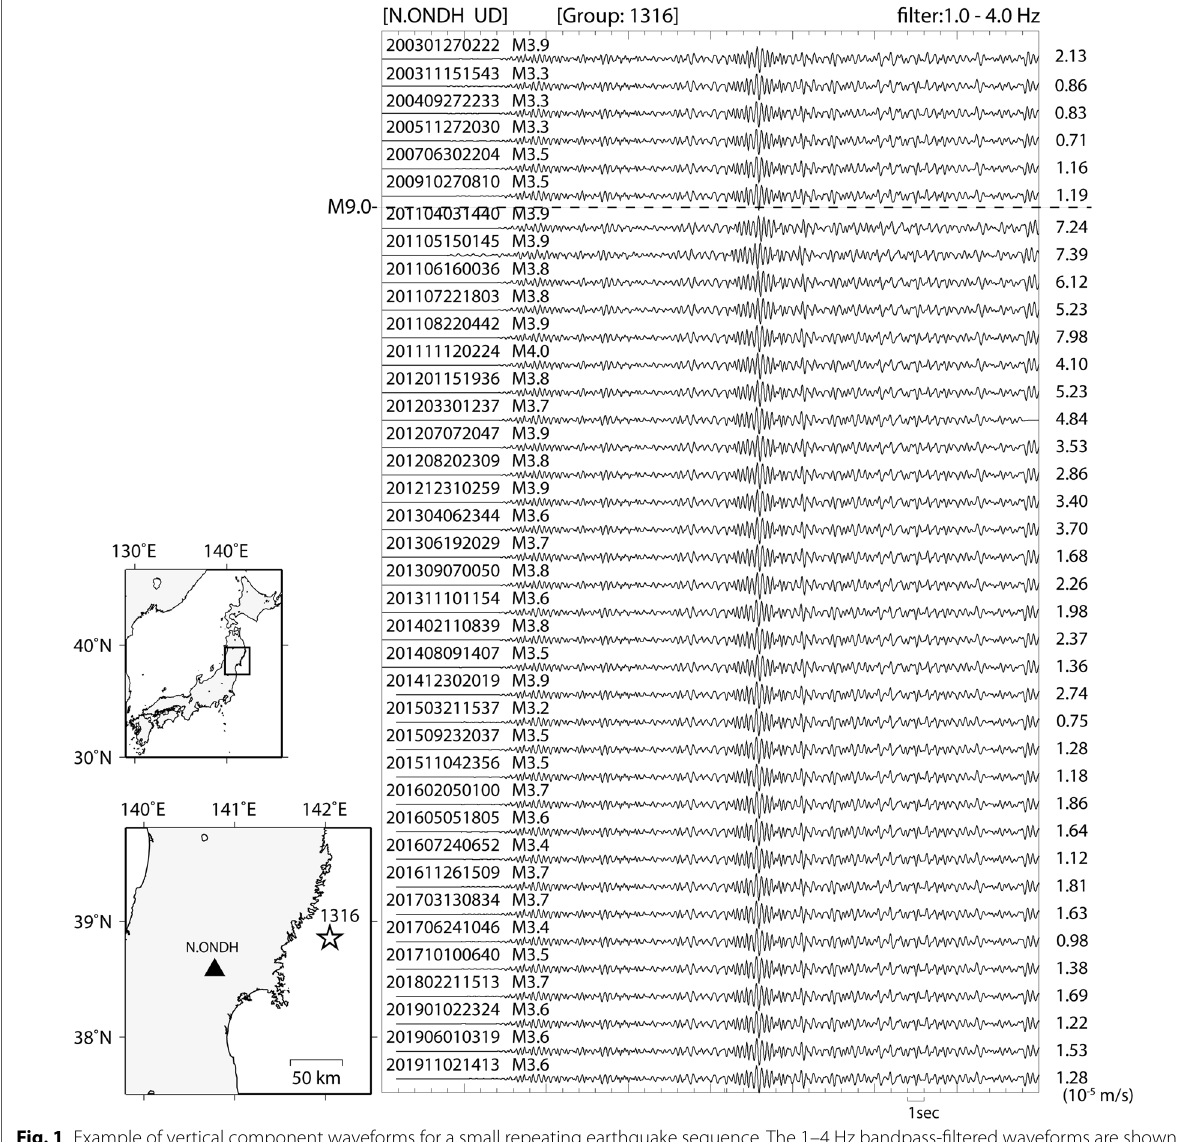
Fig. 1 Example of vertical component waveforms for a small repeating earthquake sequence. The 1–4 Hz bandpass-filtered waveforms are shown. The onset (YYYMMDDHHMMSS format) and JMA magnitude of each earthquake are listed on the left side of each trace. Each trace is normalized by the maximum amplitude, which is shown at right. The timing of the 2011 Mw 9.0 Tohoku-Oki Earthquake is indicated by the dashed line. The inset map shows the locations of the repeating earthquake sequence (Group 1316; star) and the seismic station that recorded the waveforms (N.ONDH;